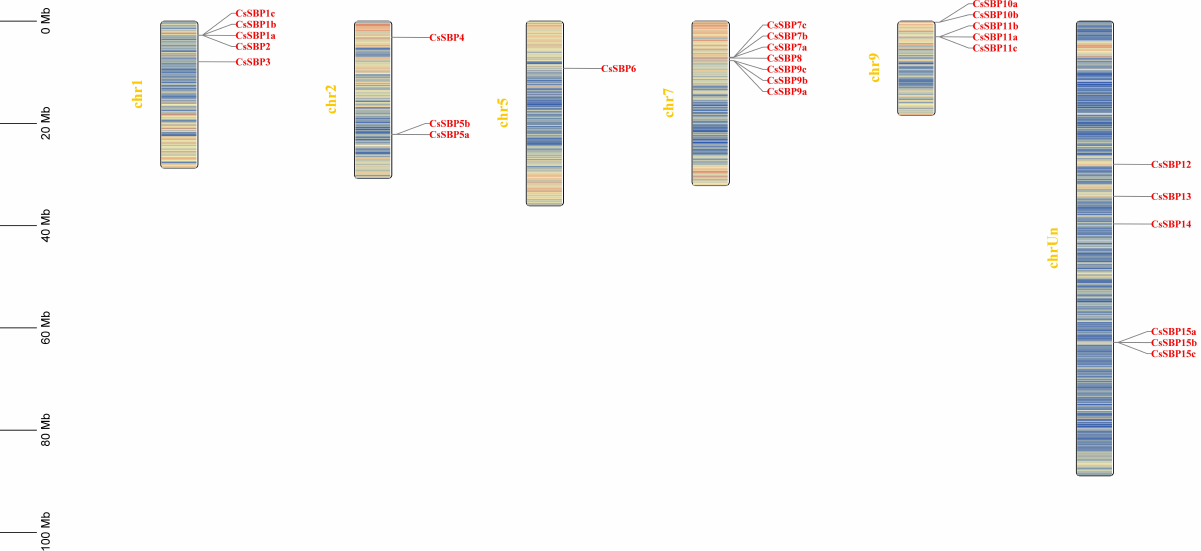
Figure 2. Chromosomal location of CsSBP genes. The scale represents 100 Mb chromosomal distance. The chromosome numbers are labeled above them. Gene densities were drawn based on the annotation information of C. sinensis